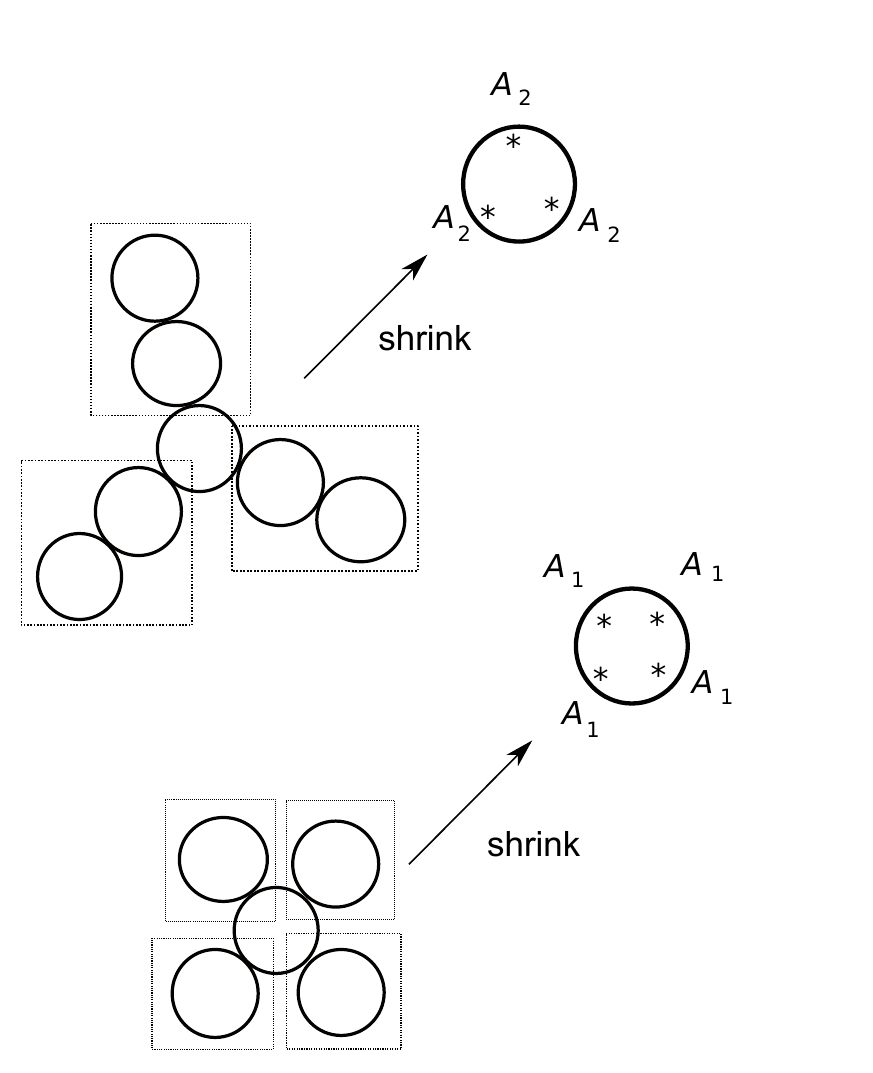
Figure 13. Analogy with Gaiotto curves. In the top part of the (cid:12)gure, a Kodaira (cid:12)ber of type IV (cid:3) is shrunk to a sphere with three punctures reminiscent of the Gaiotto curve of the E 6 Minahan- Nemeschansky theory. In the bottom part, the analogous procedure is shown for a (cid:12)ber of type I (cid:3) which shrinks to the four-punctured sphere reminiscent of the Gaiotto curve for the N = 2 SCFT with G = SU(2) and N f =